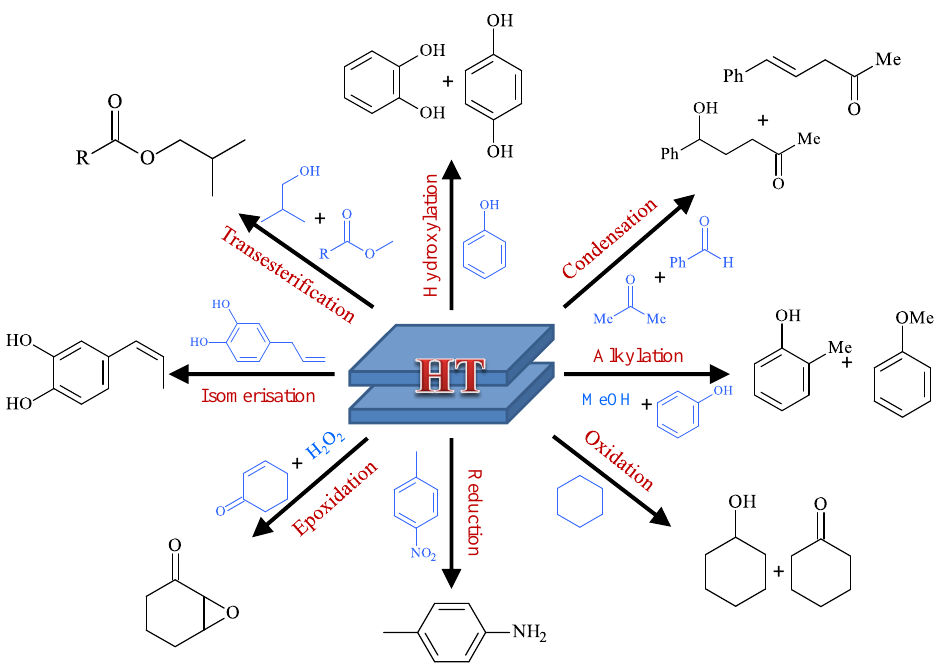
Figure 2. Schematic representation of different organic transformations. Adapted from Ref. [3], Copyright 2015, Royal Society of Chemistry.